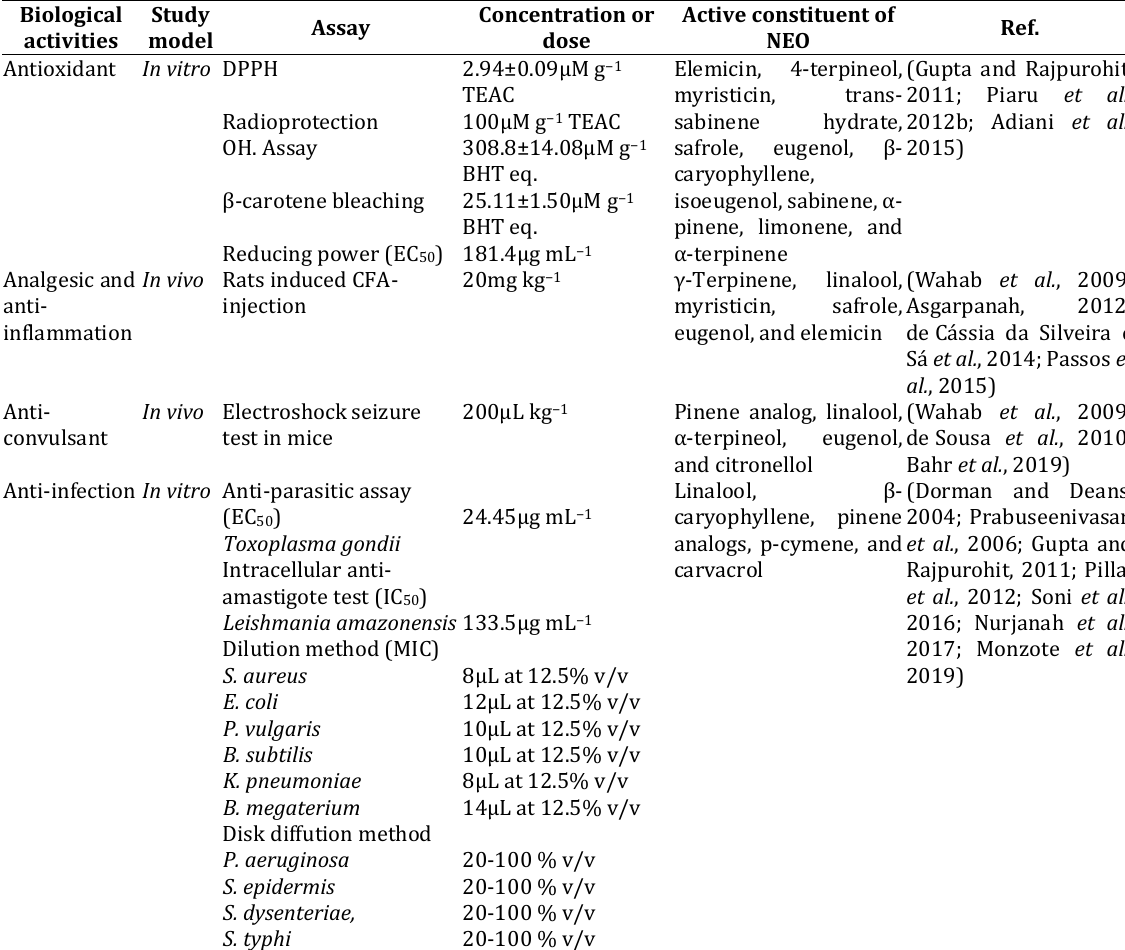
Table Ia. Myristica fragrans Houtt. essential oil bioactivities